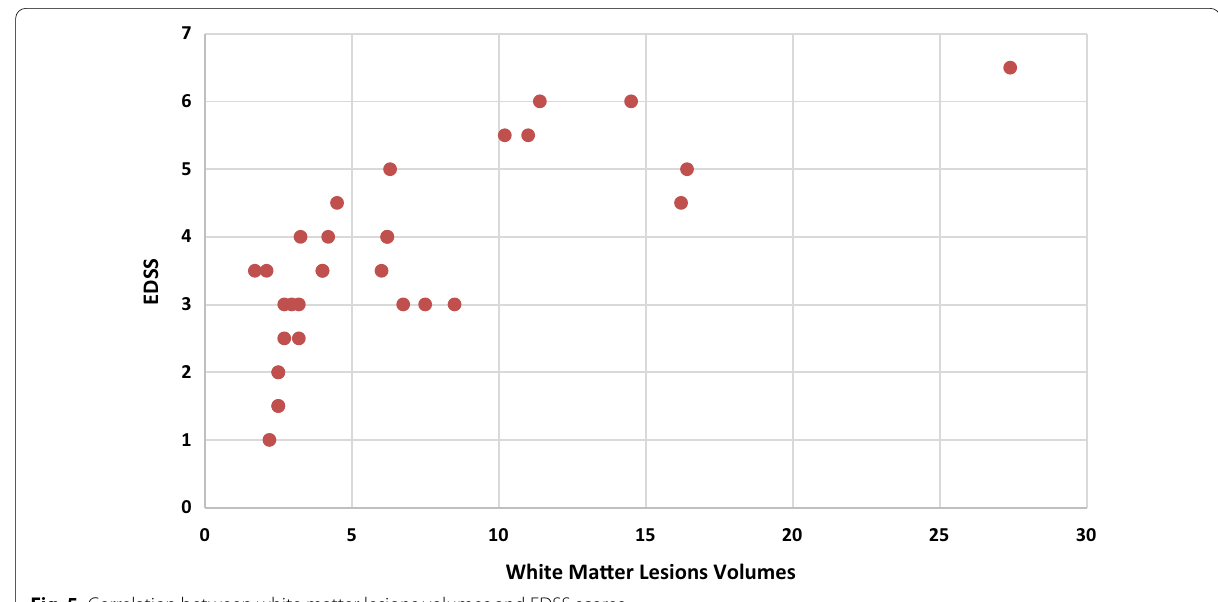
Fig. 5 Correlation between white matter lesions volumes and EDSS